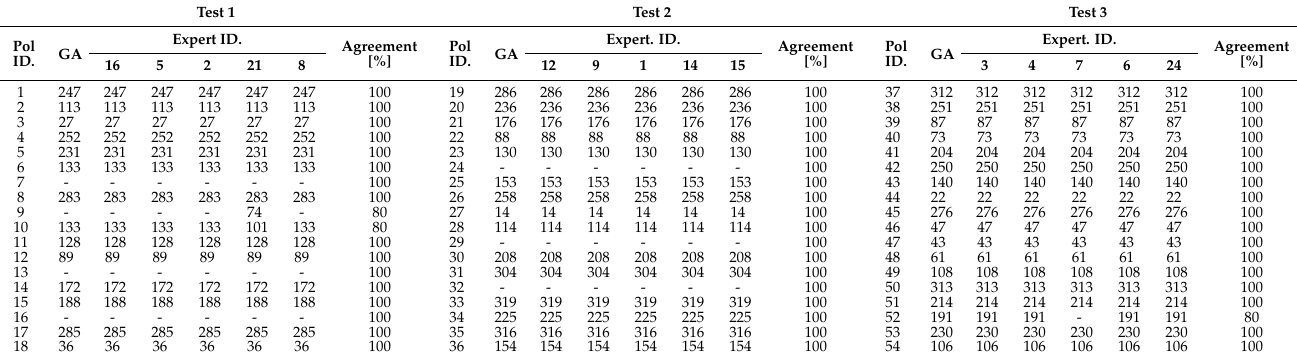
Table A5. Results provided by the experts vs GA. Matching experiment (Tests 1, 2 and 3).